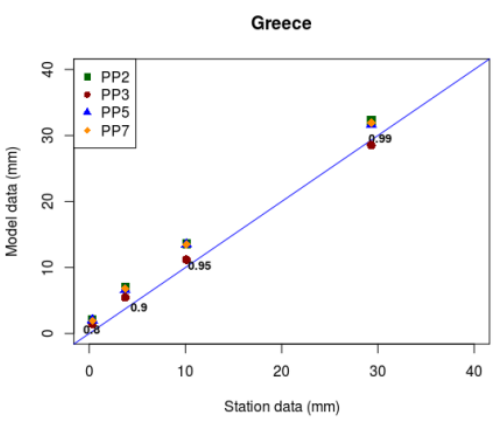
Figure 5. Percentiles of daily precipitation for the four WRF simulations vs. observational percentiles for the region of Greece and some indicative stations. Straight (blue) line represents the perfect performance.